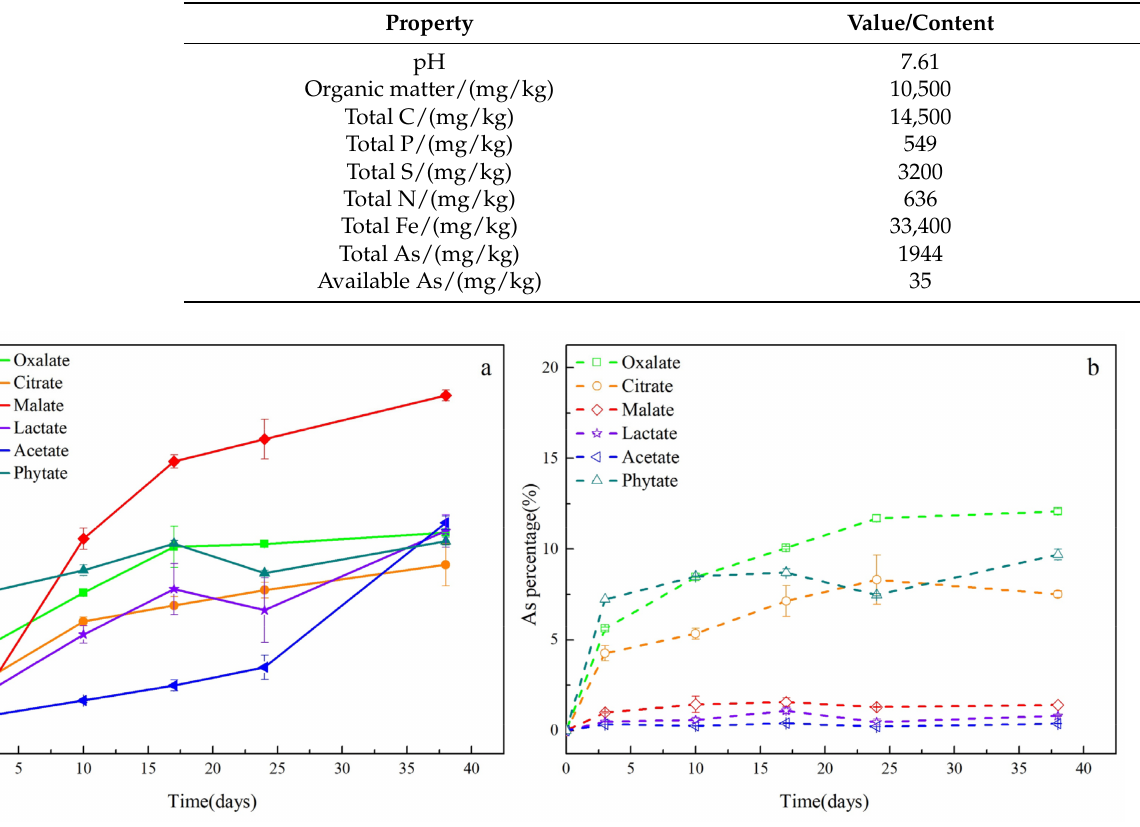
Figure 1. Dissolved As release as a percent of total As in soil under biotic ( a ) and abiotic ( b ) conditions with different LMWOAS amendments in unremediated